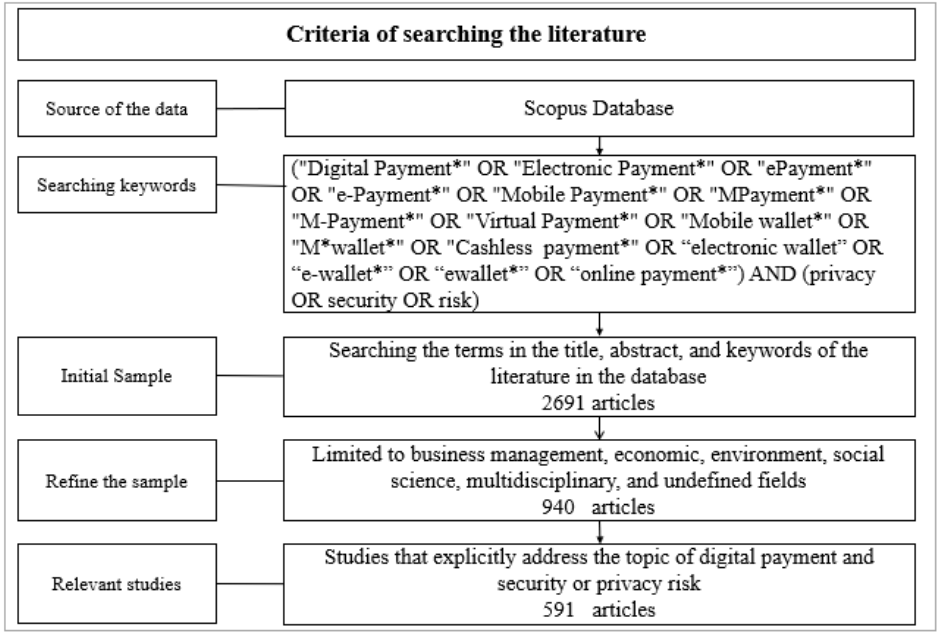
Figure 1. The flow chart of collecting the literature. Note: The asterisks such as in ‘payment*’ are used to find all derivatives of the word payment.